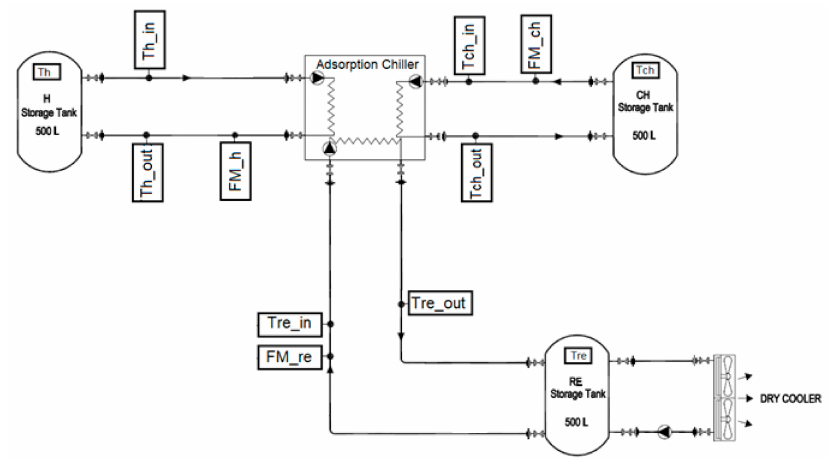
Figure 4. Schematic of prototype adsorption chiller testing equipment.